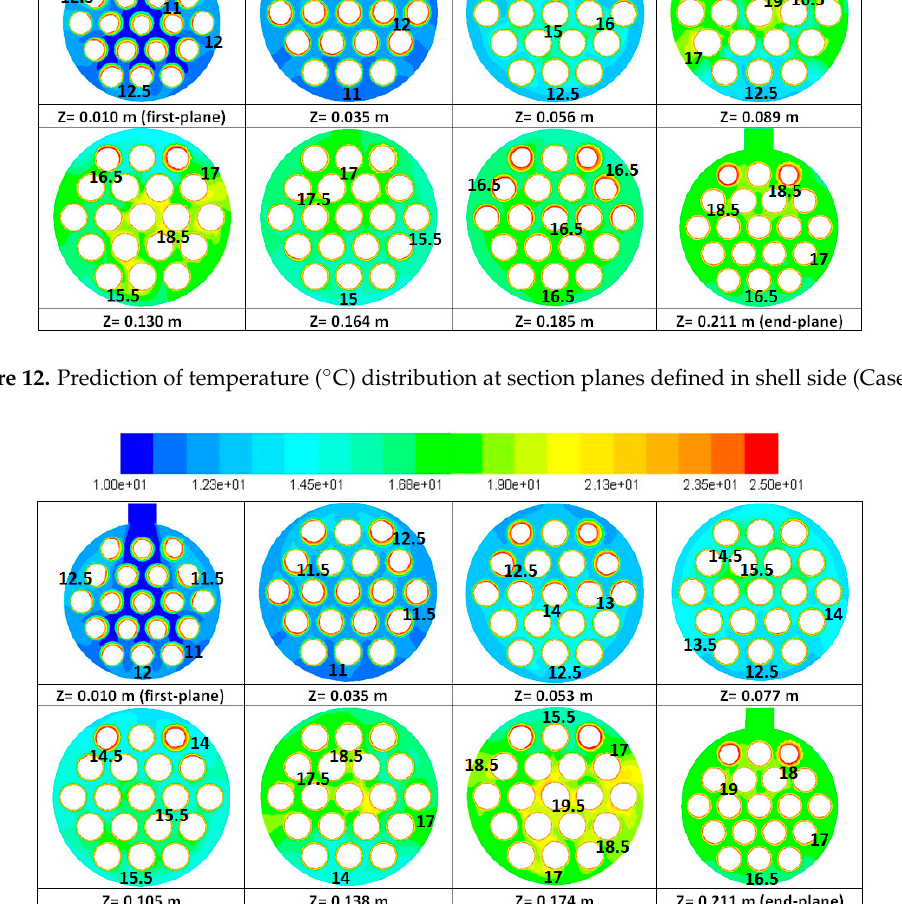
Figure 13. Prediction of temperature (°C) distribution at section planes defined in shell side (Case-IV).